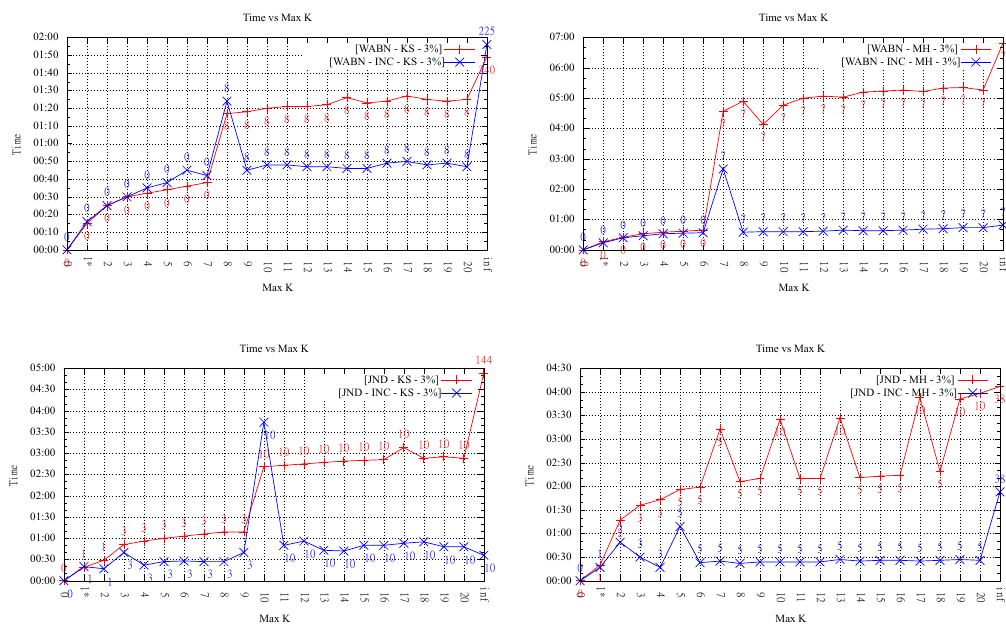
Figure 9. Running times for Kinzel Springs (left) and Moorehead SE (right) for 3% sample set size as the maximum order k increases, for ABN, WABN and JND. * Analysis for the exact algorithms is presented in Section 4.4; thus, results for those algorithms are not exhibited